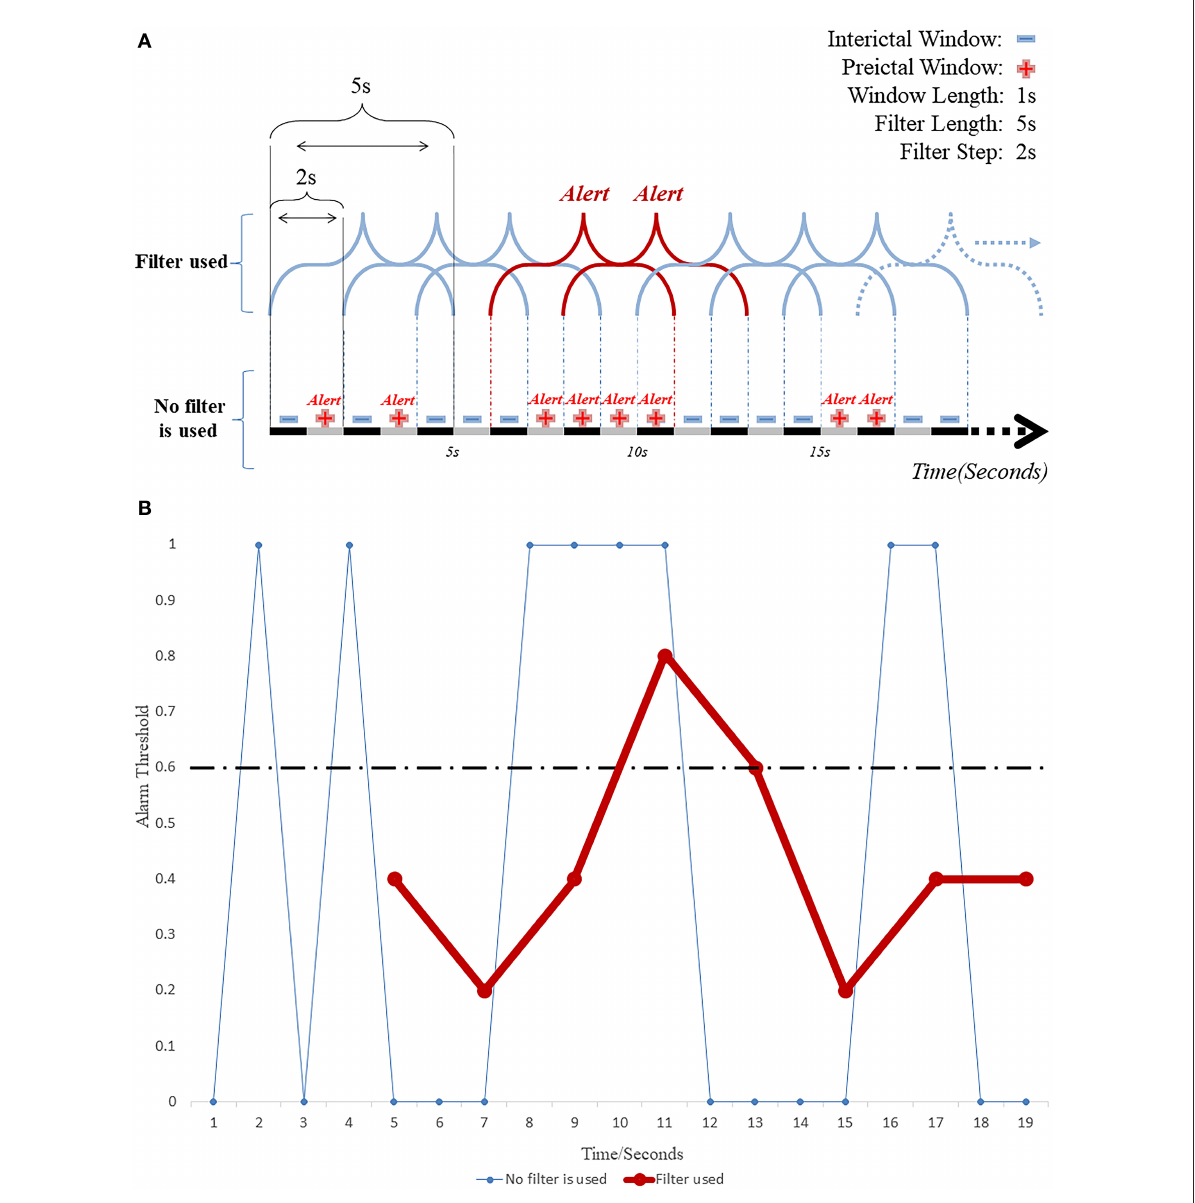
FIGURE4 (A) Working diagram of EEG windows and the moving filter length and step size. (B) The repeated invalid early warning information is greatly reduced by filtering